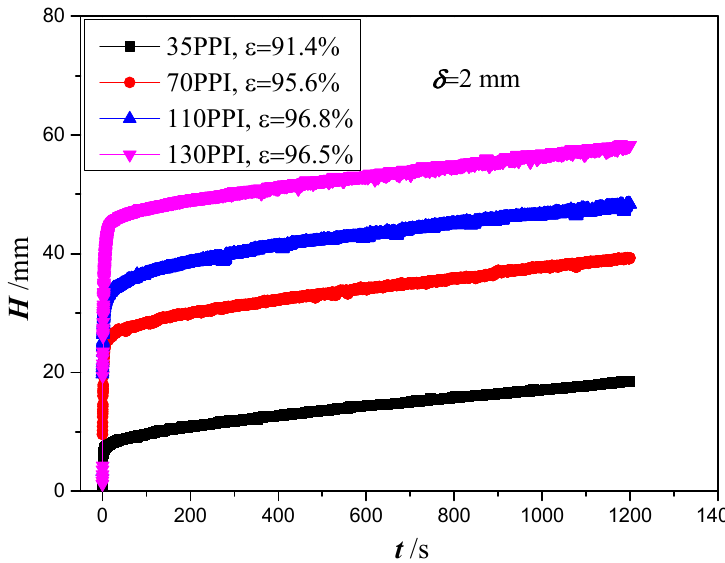
Figure 8. Wicking height versus time in copper foams with different PPI.